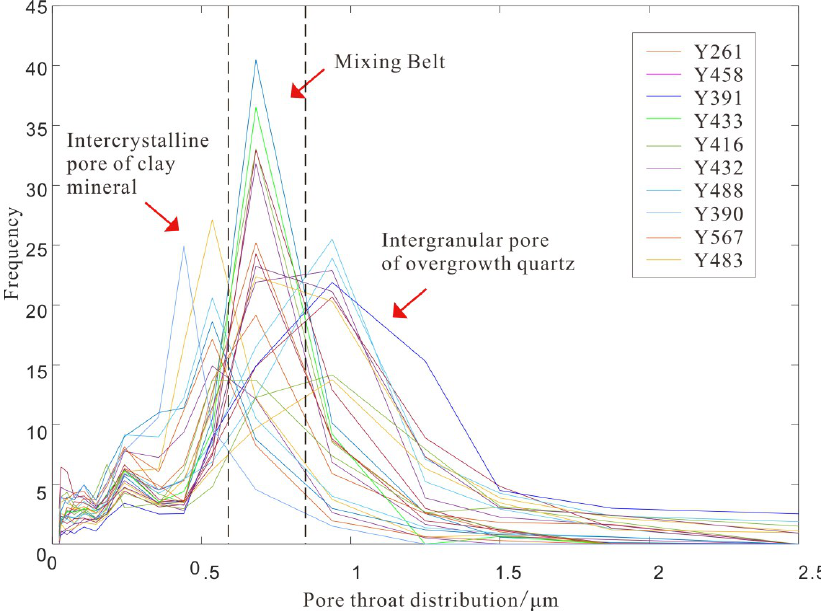
Figure 8. Distribution of pore throat based on a high-pressure mercury injection experiment.